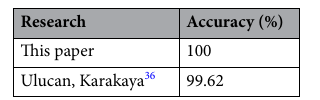
Table 5. Comparison of this paper with the existing